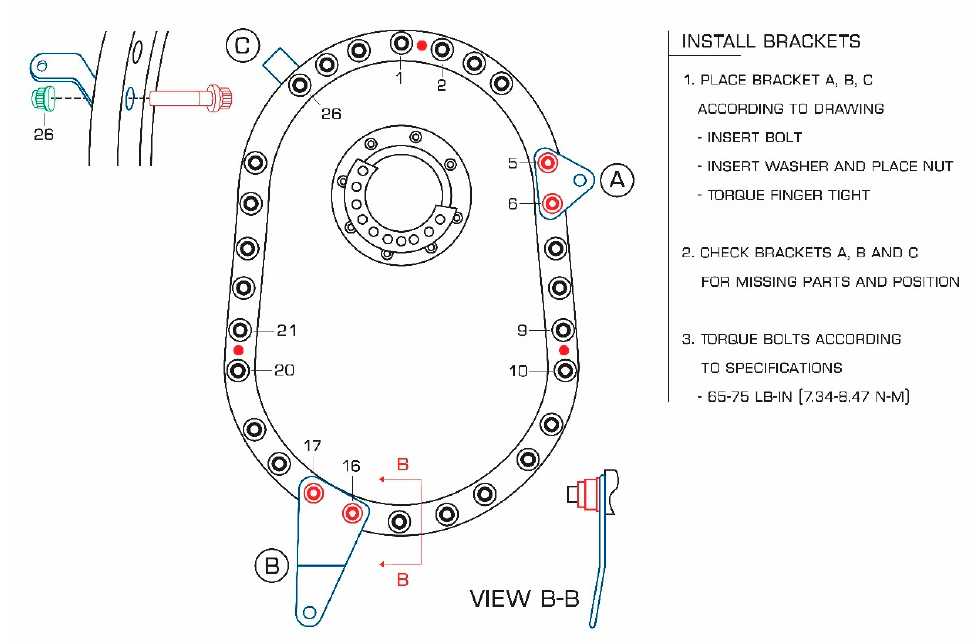
Figure 5. 2D drawing showing the exact location where brackets A, B and C should be installed.